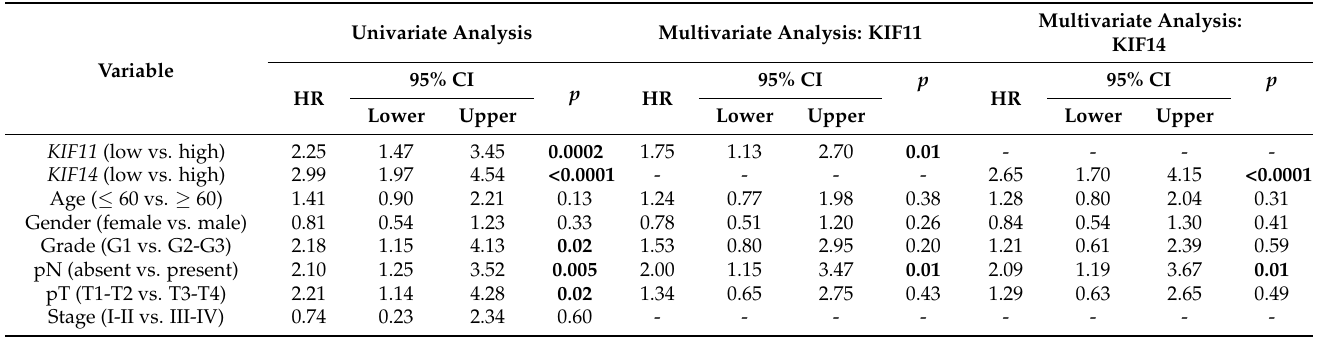
Significant p -values ( p < 0.05) are marked in bold. Abbreviations: CI, confidence interval; HR, hazard ratio; TCGA, the Cancer Genome Atlas. HR: adjusting for age, gender, histological grade, pN, pT, and each marker separately. Owing to the strong correlations between KIF11 and KIF14 mRNA levels, they were not included in the same multivariate model. “-“ indicates variable was not included in multivariate Cox